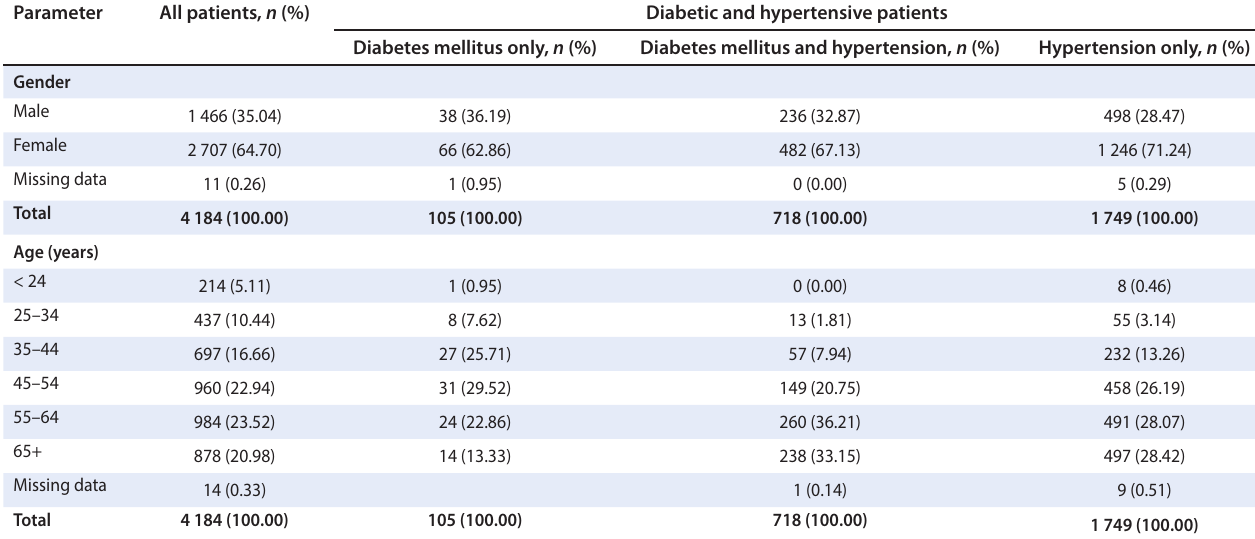
Table 1: Demographic information of the patients attending the different community health centres Parameter All patients, n